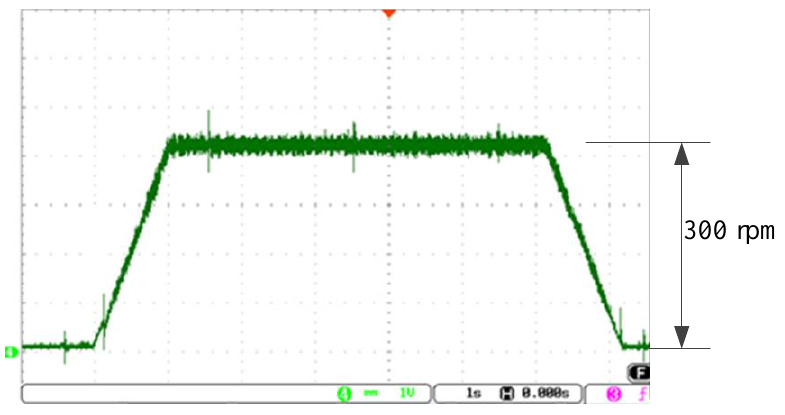
Figure 21. The trapezoidal velocity profile (70 rpm/div).